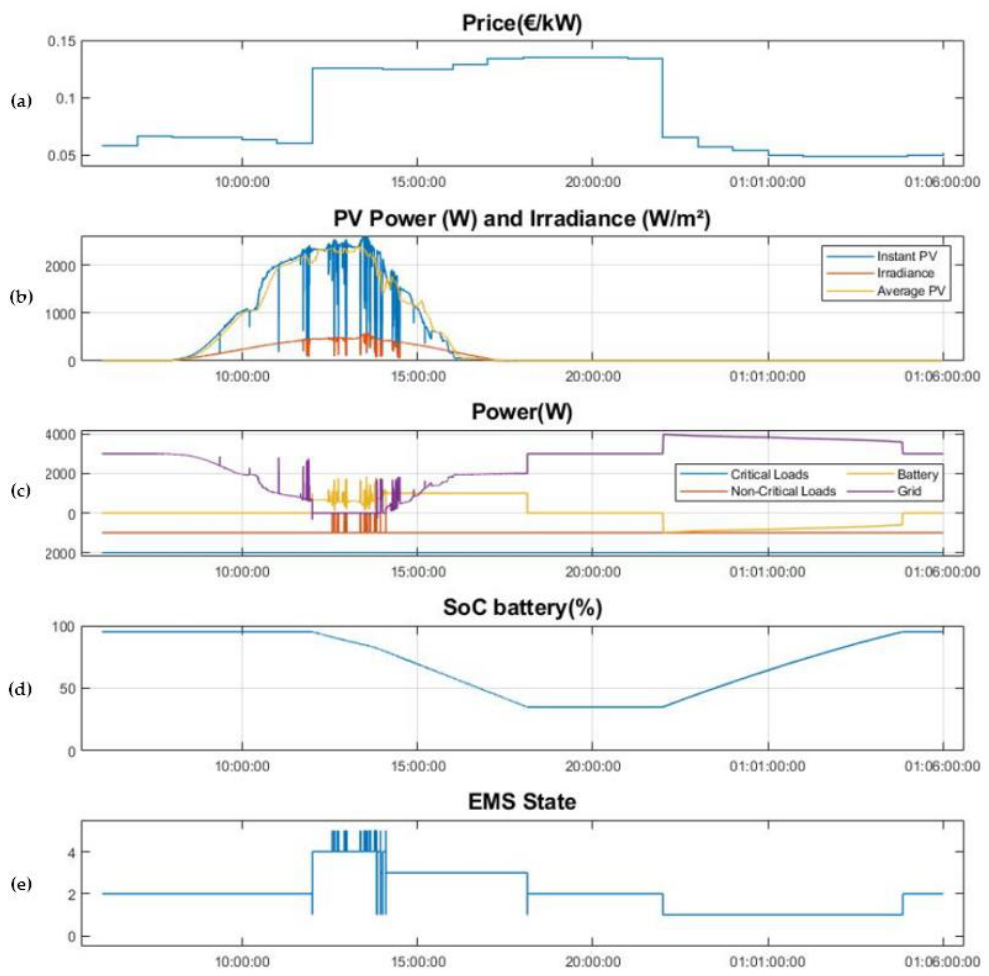
Figure 15. Use Case: ( a ) energy prices in the market for the day under study; ( b ) Instant Power PV production, Average power PV over the last 15 min and irradiance; ( c ) Power consumed by critical and non-critical loads, power consumed and delivered by the BESS and power delivered by the grid; ( d ) SoC level of the battery; ( e ) EMS states.